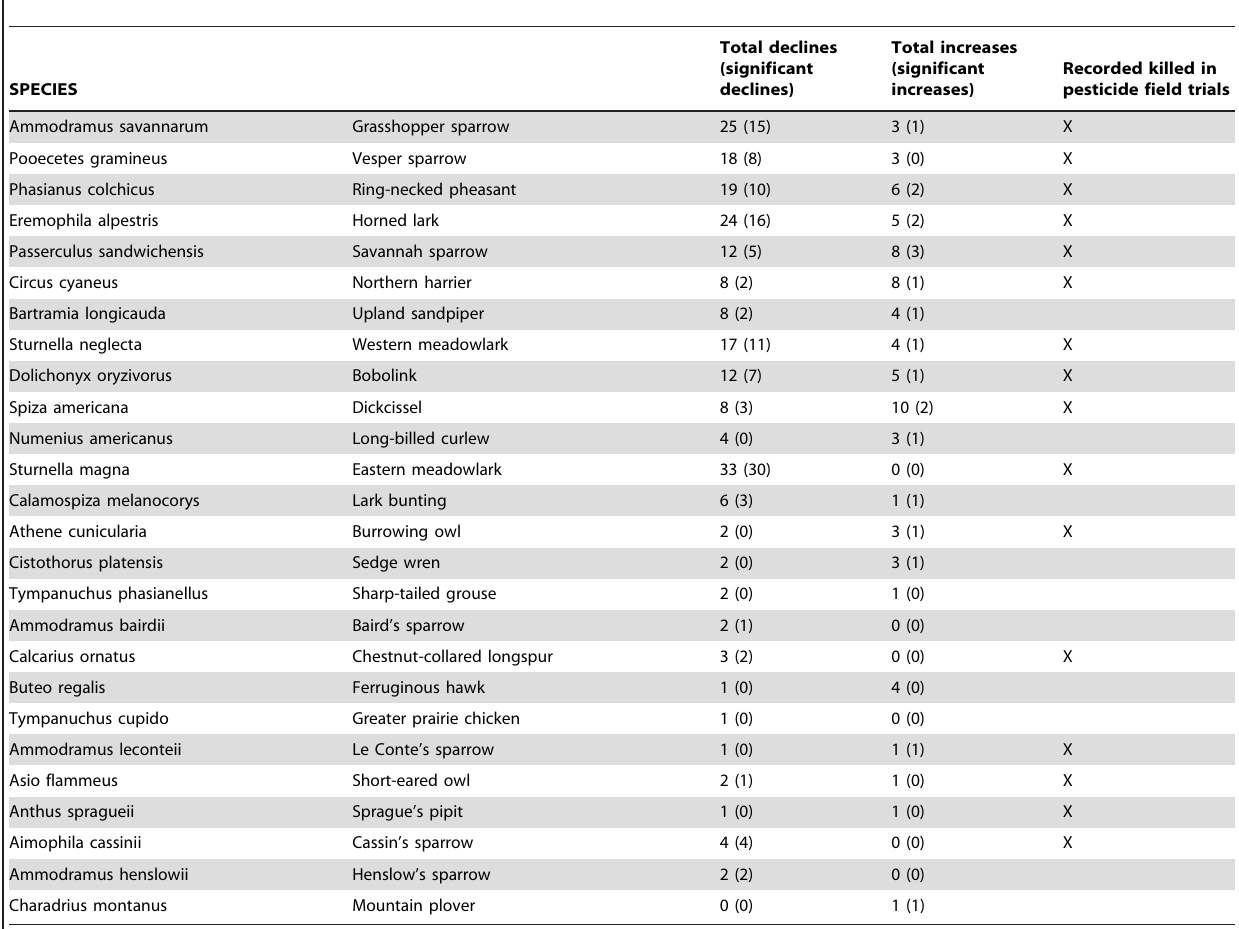
Table 1. Grassland species ordered by the number of total state*species declines and the number of recorded declining or increasing trends (1980–2003) for the 45 conterminous American